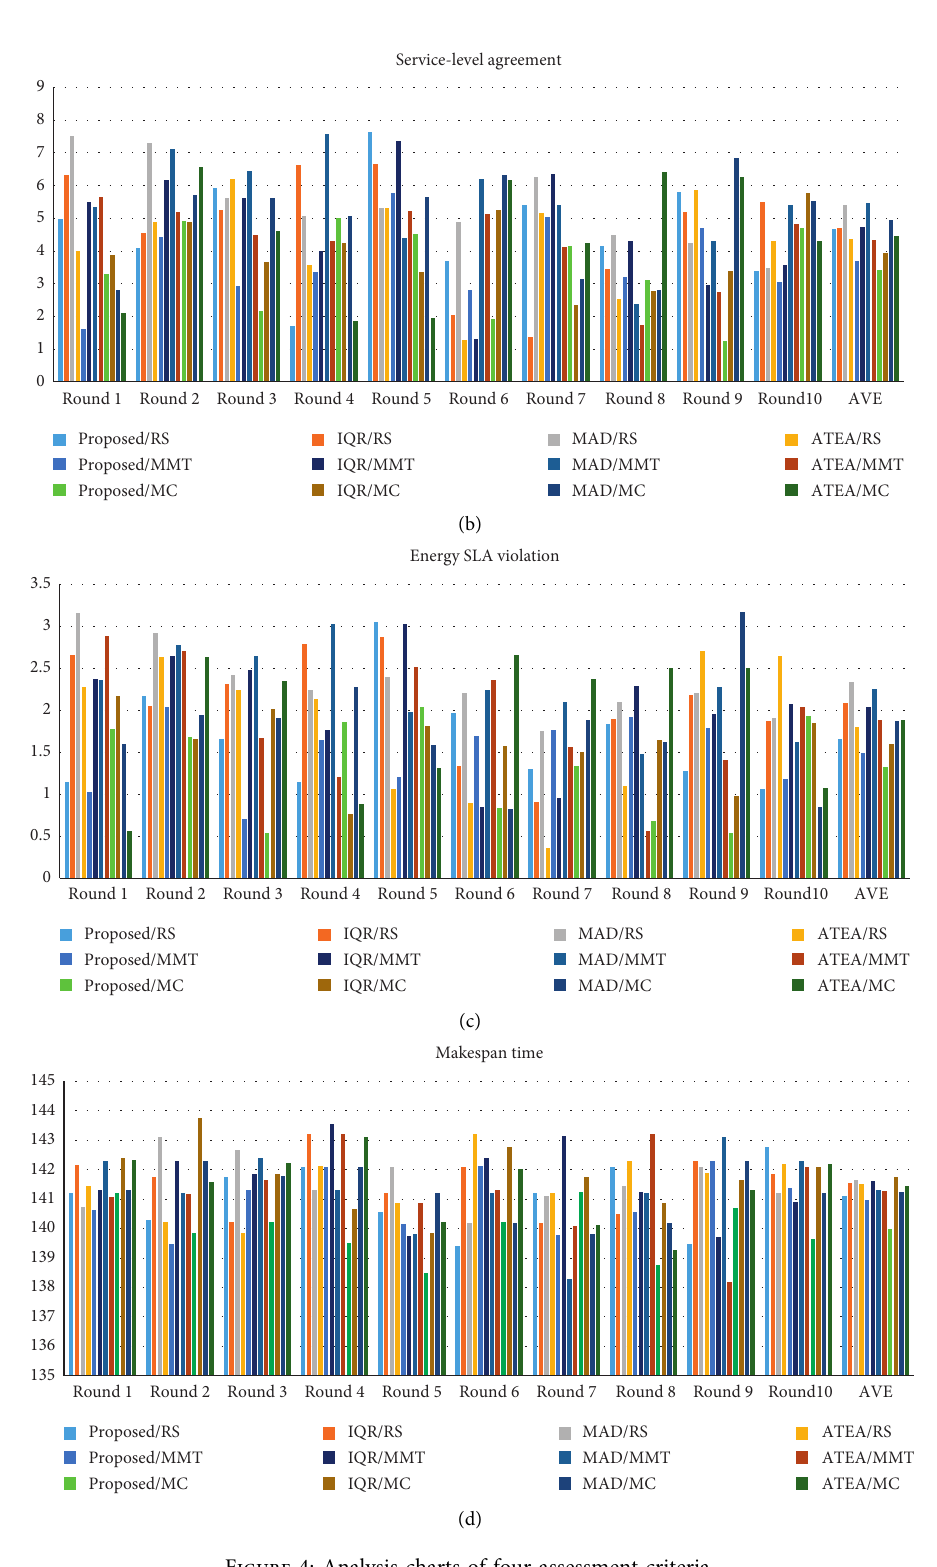
Figure 4: Analysis charts of four assessment